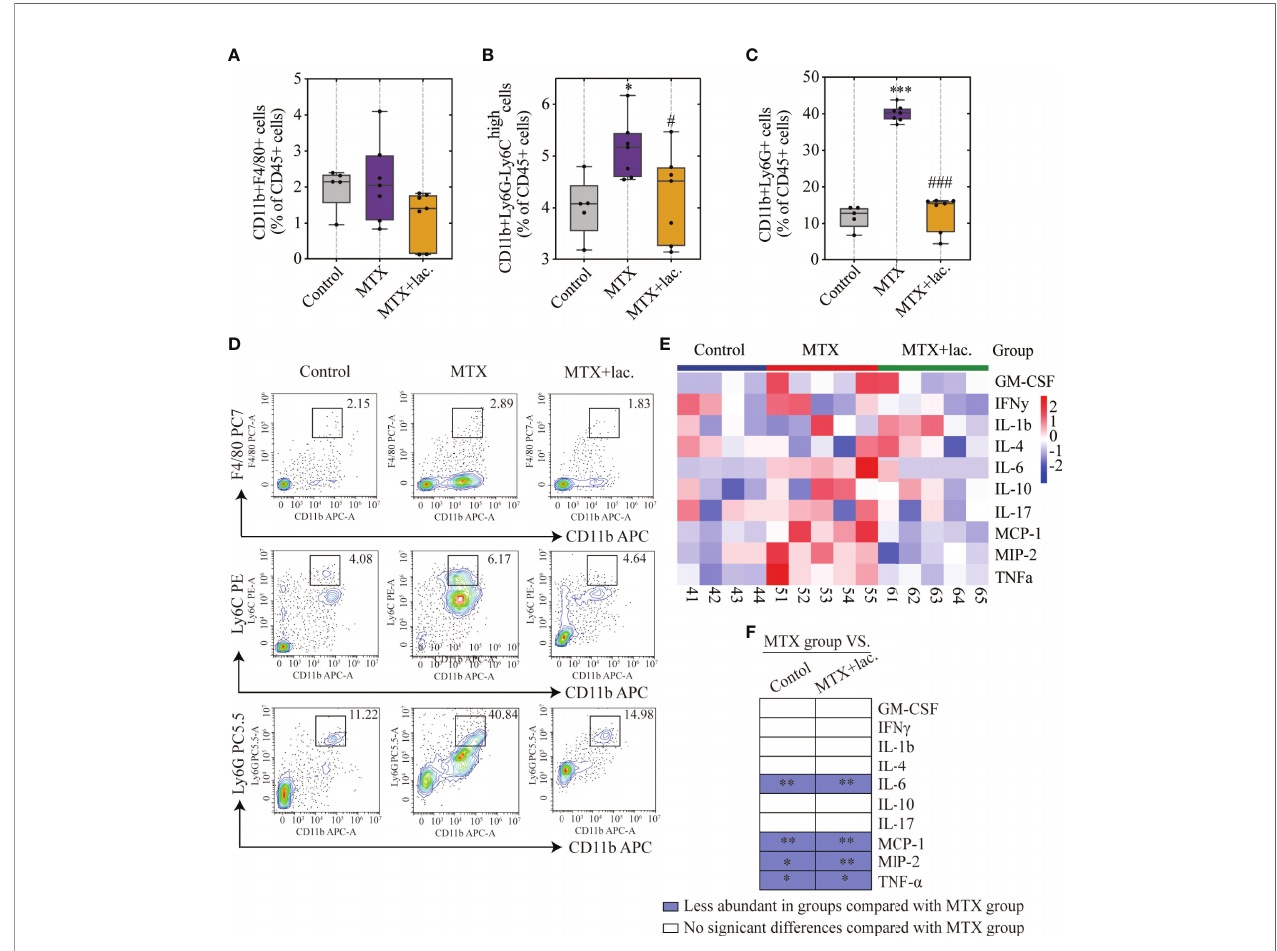
FIGURE 8 | Lactobacillus. sp. reduced MTX-induced in fl ammation levels in liver and serum. (A – D) FACS staining of immune cells in the liver represented as percentages of CD45+ cells. (E) Heatmap of speci fi c cytokine and chemokine levels in serum, including IFN- g , IL-4, IL-6, GM-CSF, IL-1 b , IL-17, IL-10, TNF- a , MIP-2, MCP-1 (n=4-5). (F) Cytokines and chemokines from panel L and comparisons of MTX and other groups. Blue entries indicate cytokines/chemokines that were less abundant in various groups compared to the MTX group. *p < 0.05, **p < 0.01, ***p < 0.001, compared with Control group. # p < 0.05, ### p < 0.001, compared with MTX